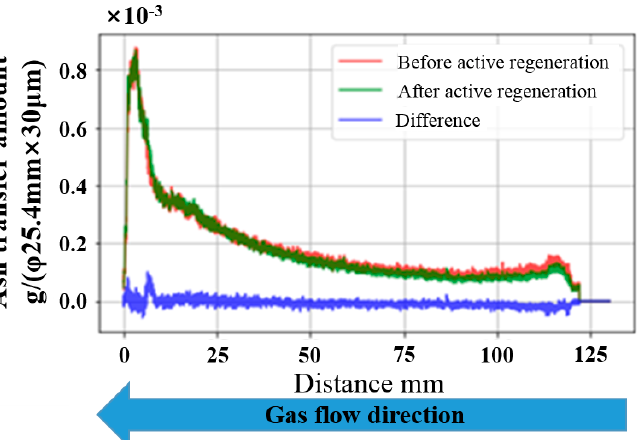
Figure 2. Ash transport during active regeneration (Waseda University with the National Institute of Advanced Industrial Science and Technology in Japan).